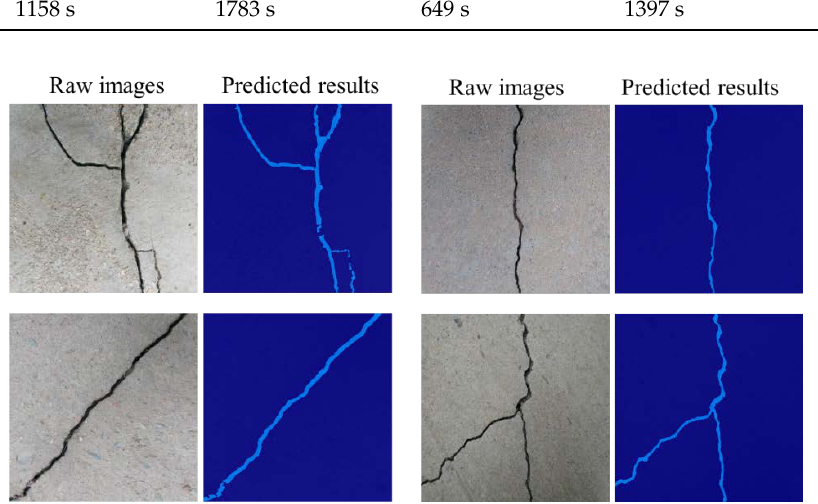
Figure 11. Detection results of the DeepLab_v3+ with ‘resnet5 0′ . Table 3. Segmentation results of different DeepLab_v3+ models.